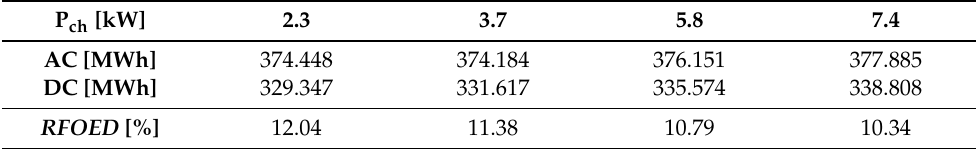
Table 4. Feed-out energy from the grid for the 100% EV and 100% PV